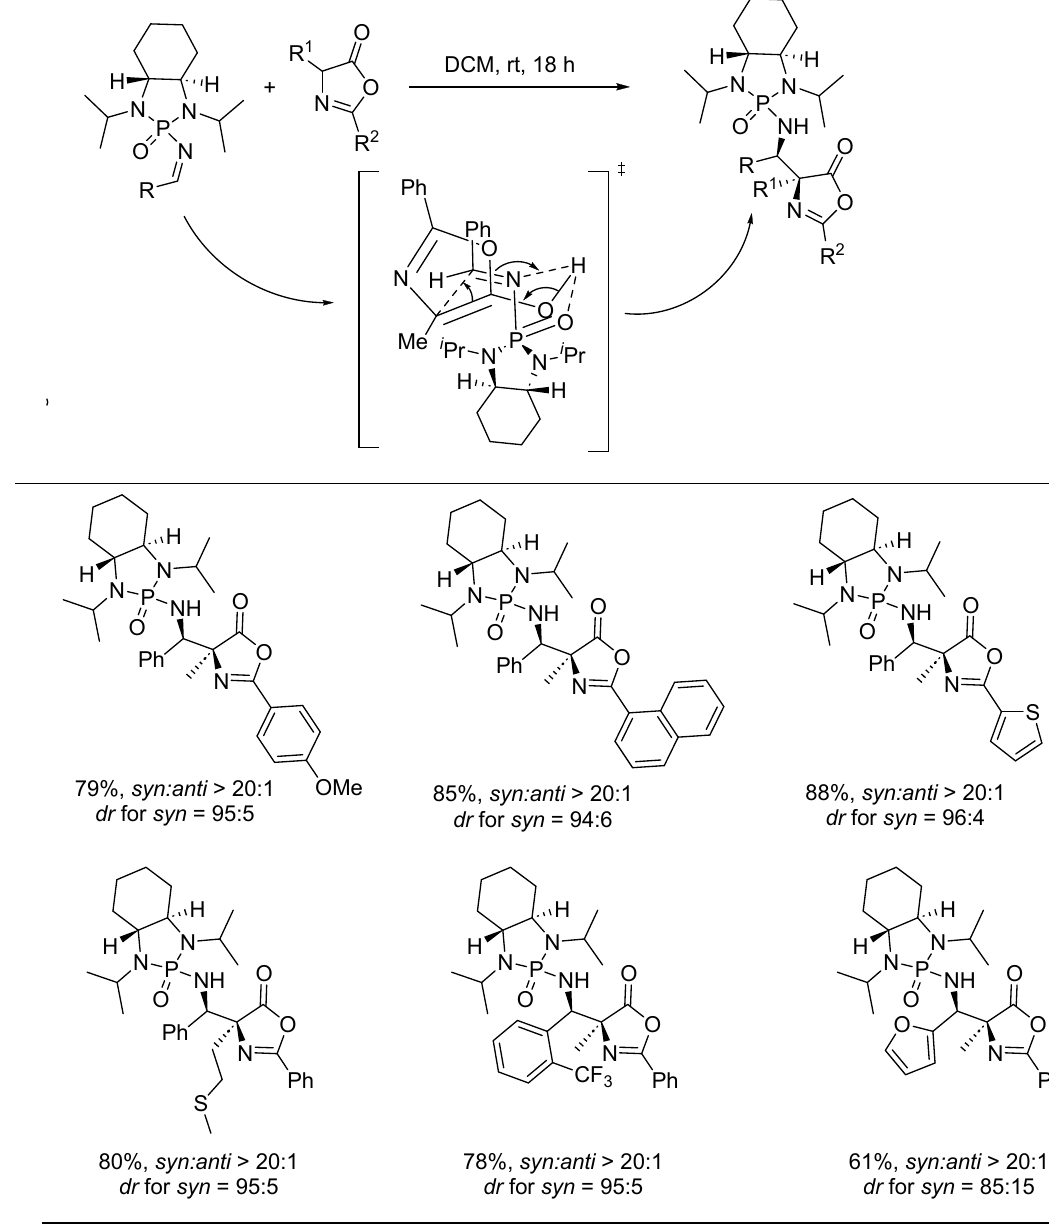
Scheme 8. Mannich reaction of azlactone with chiral N -phosphonyl G. Li and coworkers established an e ff ective protocol for the synthesis of chiral α - amino phosphonates in high yields and diastereoselectivities (up to 99:1) via hydrophos- phorylation of chiral N -phosphonyl imines with the phosphites in the presence of lithium metal (Scheme 9) [51]. The bases implemented for the generation of an active nucleophile